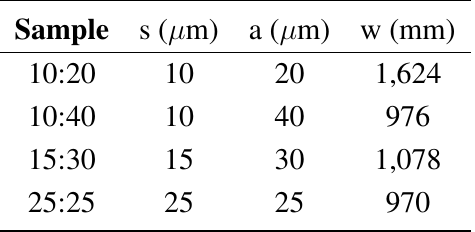
Table 1. Finger separation (s), finger width (a) and effective width of the serpentine gap between electrodes (w) of the four